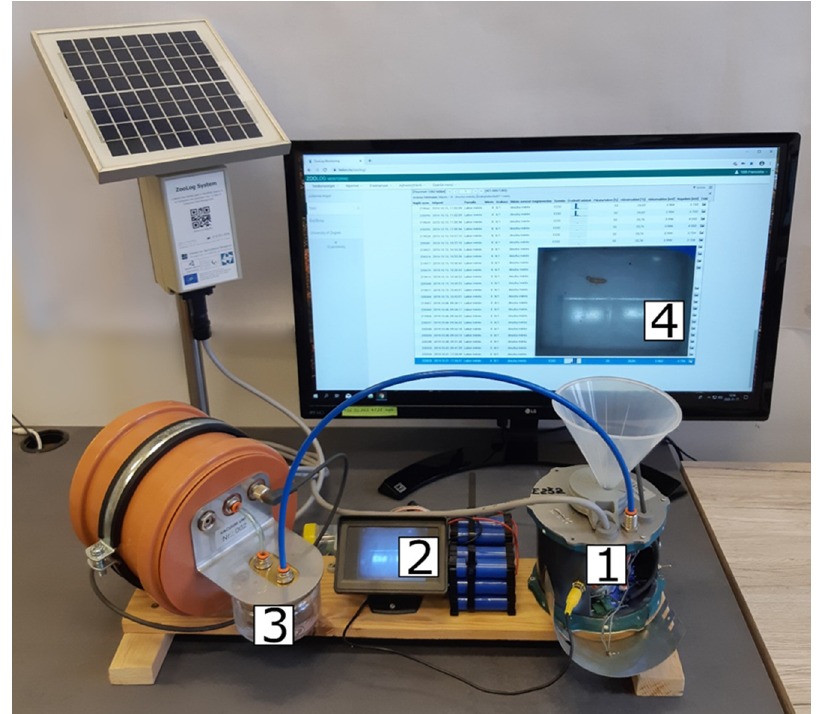
Figure 3. Testing the sensor processes on a desktop model of the probe. ( 1 ) Detection of the fall-in of the microarthropod by the infrared sensor ring. ( 2 ) Checking if the specimen arrived at the camera chamber or not. ( 3 ) Checking if the vacuum unit could pump out the specimen from the camera chamber to the sample container. ( 4 ) Checking if the microarthropod can be seen in the photo and can be identified.